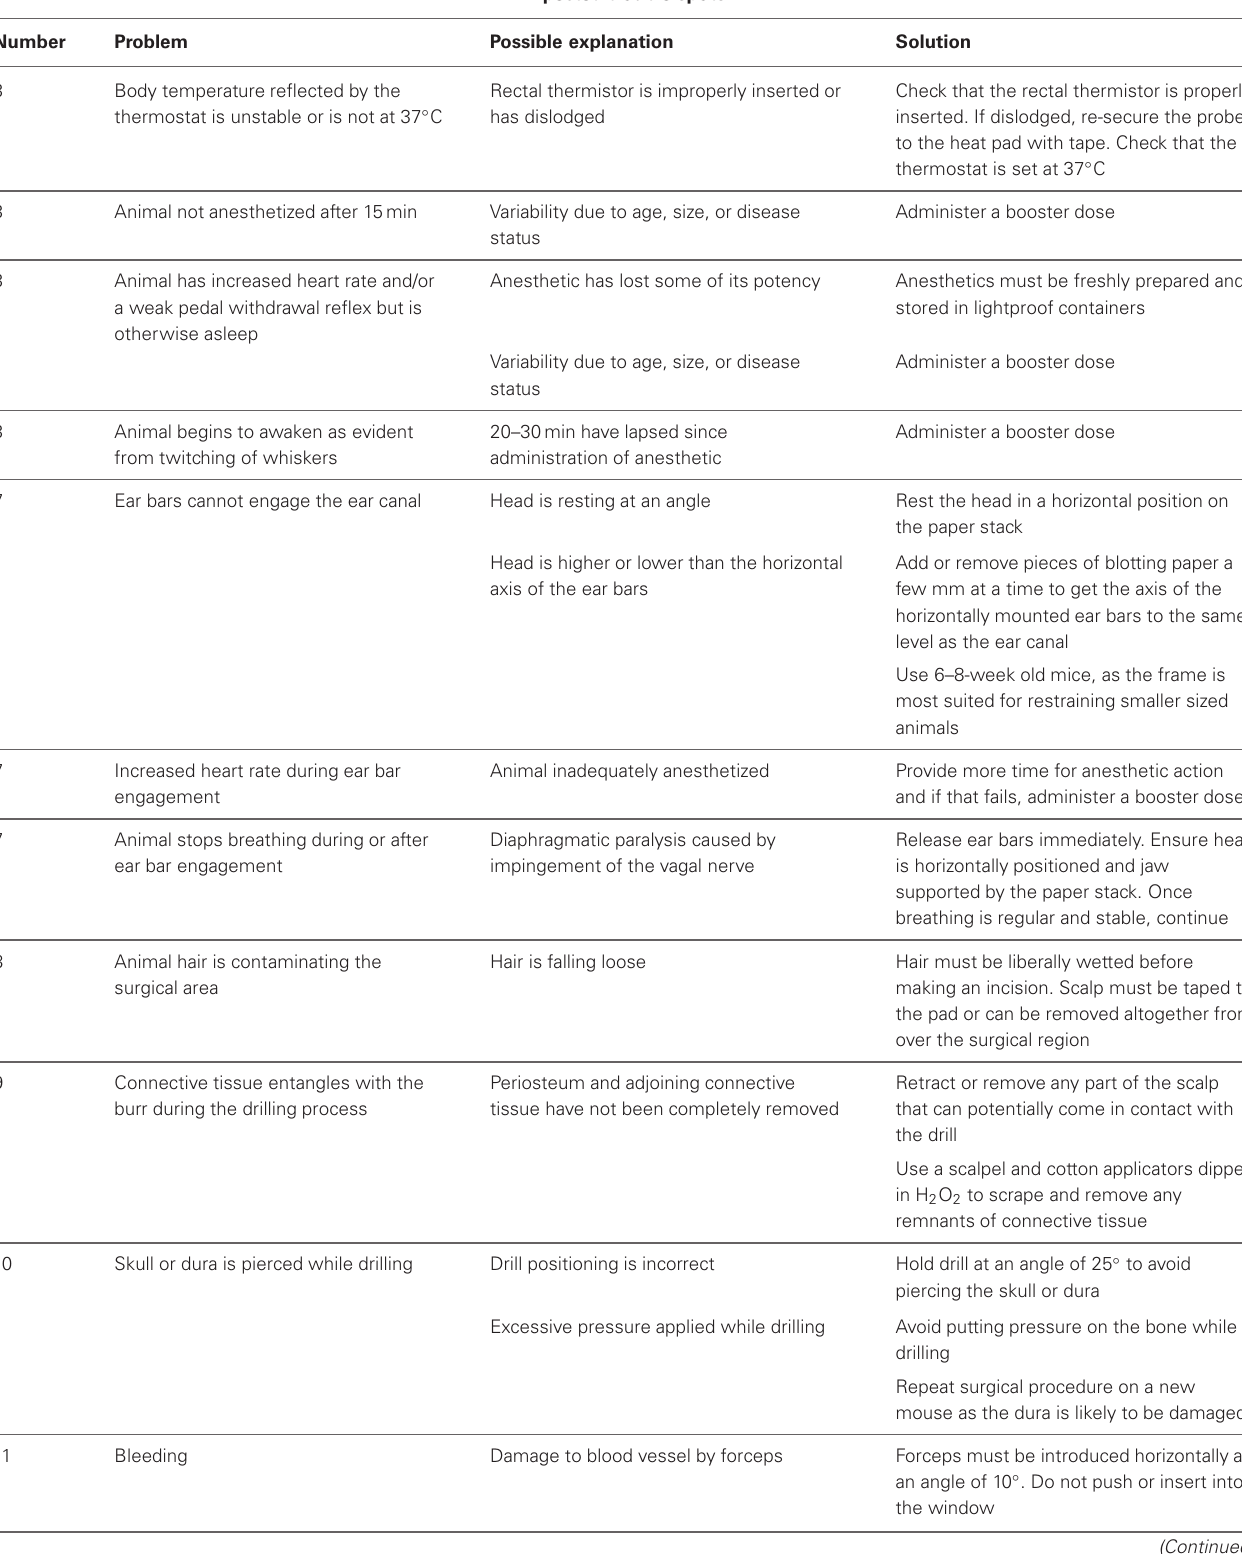
Table 1 | A troubleshooting guide to manage potential trouble